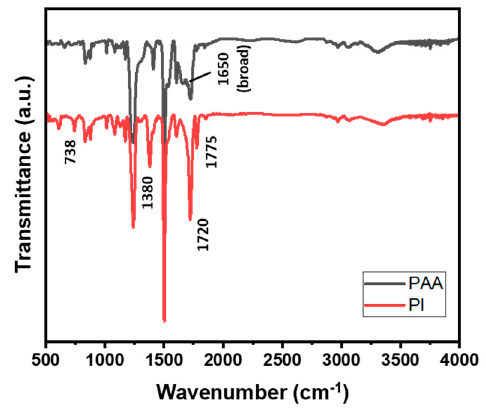
Figure 1. FTIR spectra of prepared PAA and PI thin films.